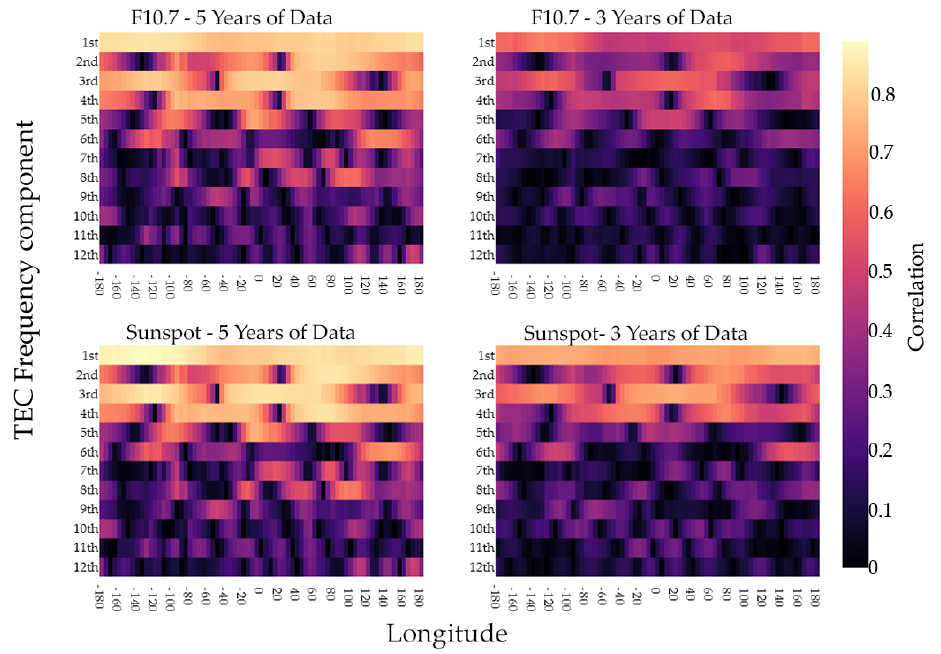
Figure 6. Correlation heatmap for F10.7 and sunspot at geomagnetic latitude 22.5 ◦ S. TEC frequency components range from 0 to 0.25